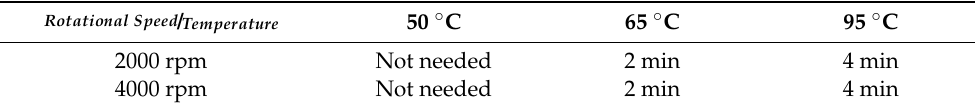
Table 2. Soft bake temperatures and times for SU-8